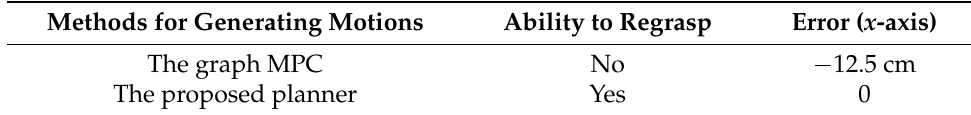
Table 2. Performances of the graph MPC and the proposed planner.